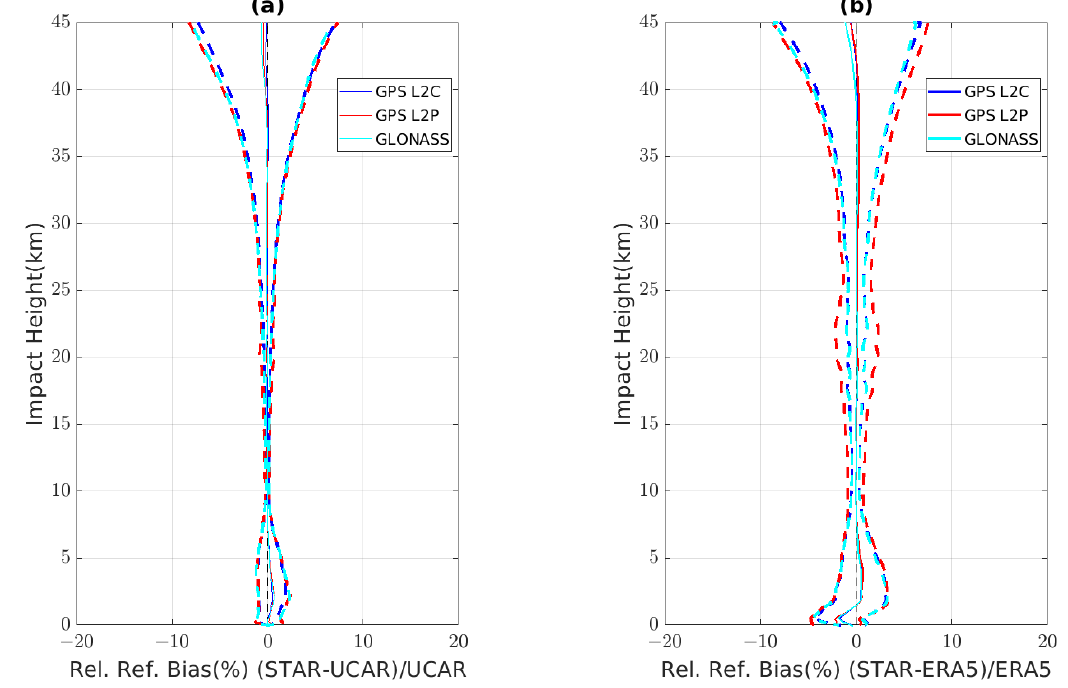
Figure 9. Refractivity Comparisons with ( a ) UCAR and ( b ) ERA5.